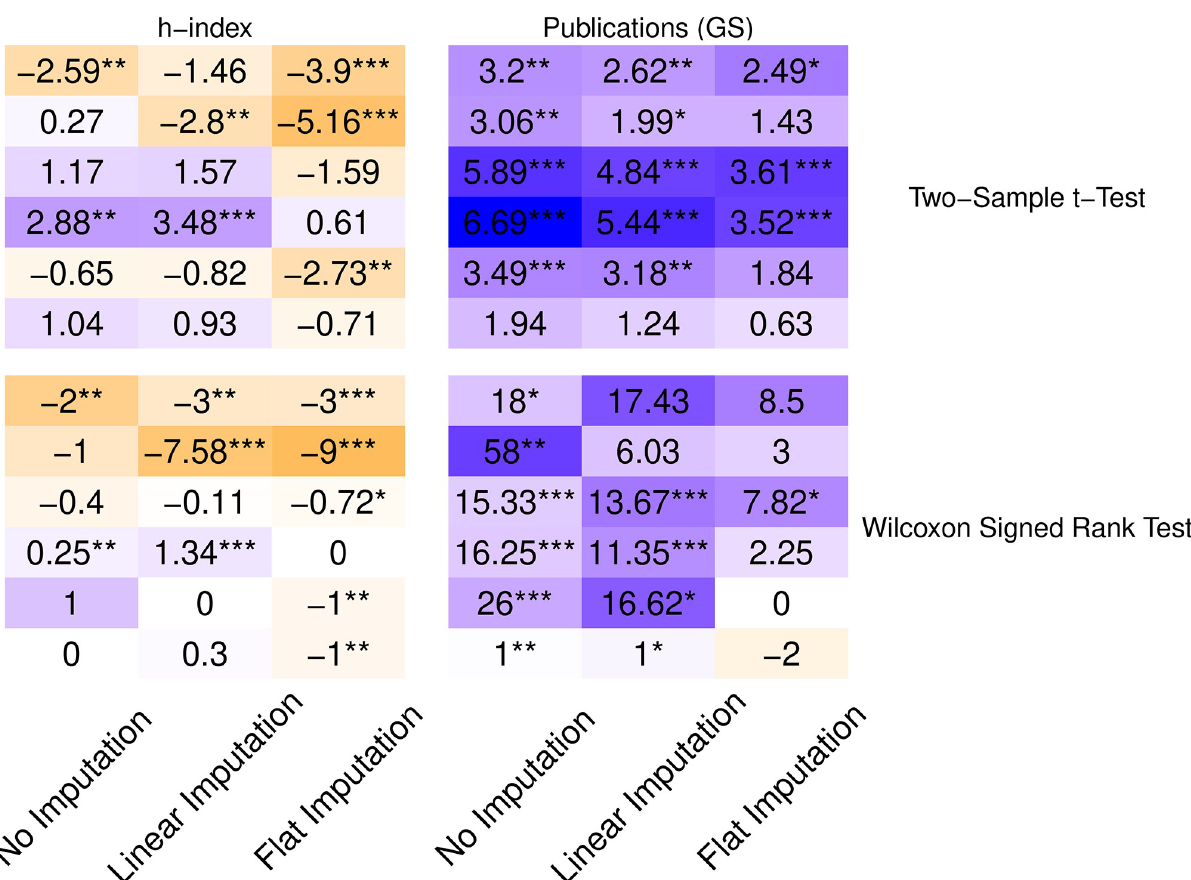
Fig 13. Test statistics of the Student’s t-test and the difference in medians for the Wilcoxon test for publications (GS) and h-index, aggregated across papers for three strategies of handling missing values. Positive values (purple) indicate higher reputation in SB conferences. Darker colors reflect larger-magnitude values, normalized by columns and test method. Negative values (orange) indicate higher reputation in DB conferences. Stars indicate p values below 0.05, 0.01, and 0.001, respectively.